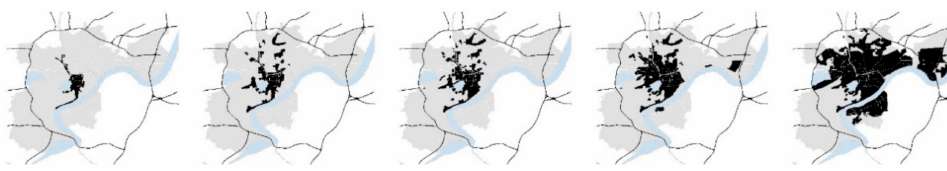
Figure 1. Built-up area of Hangzhou main city and the number of urban villages (1960–2020).